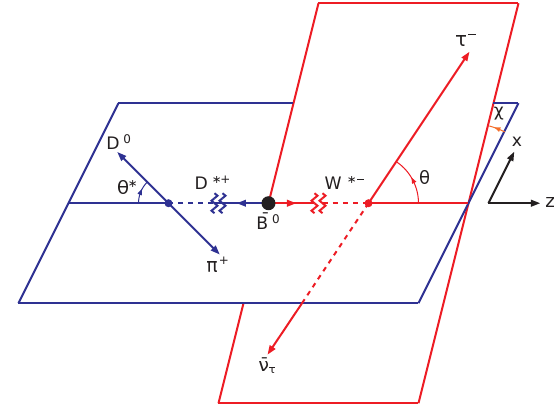
Figure 1. Definition of the angles θ , θ ∗ , and χ in the cascade decay ¯ B 0 → D ∗ + ( → D 0 π + ) τ − ¯ ν τ